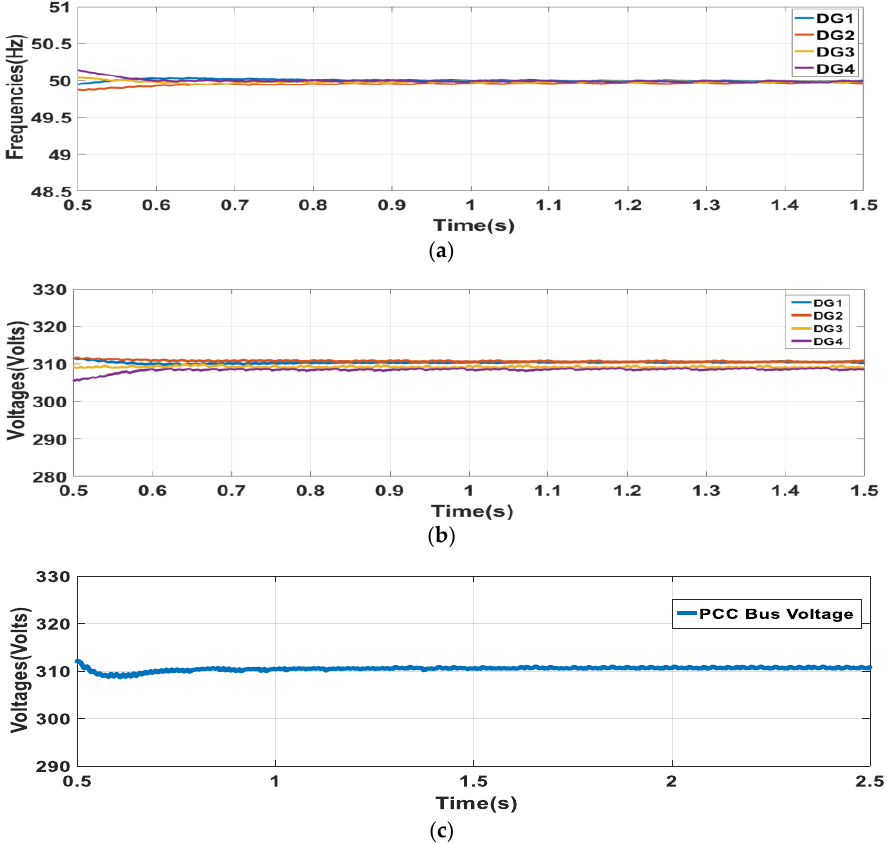
Figure 11. Outputs of 4 DGs: ( a ) frequency restoration; ( b ) voltage restoration and ( c ) point of common coupling (PCC) bus voltage restoration as in case 1.